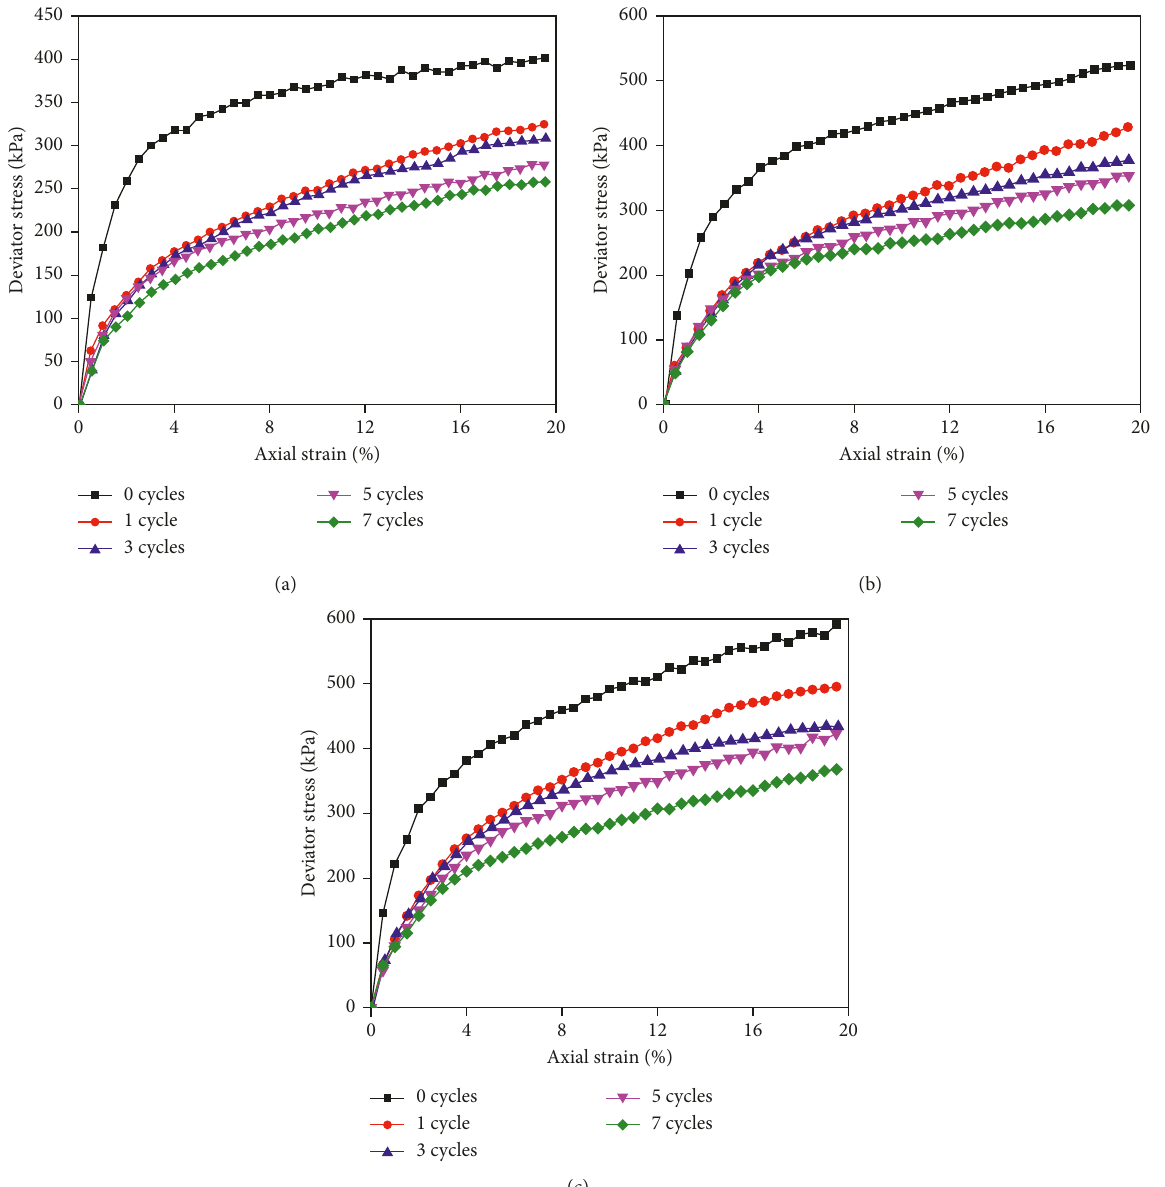
Figure 9: Deviator stress-strain curve in the closed system. (a) σ